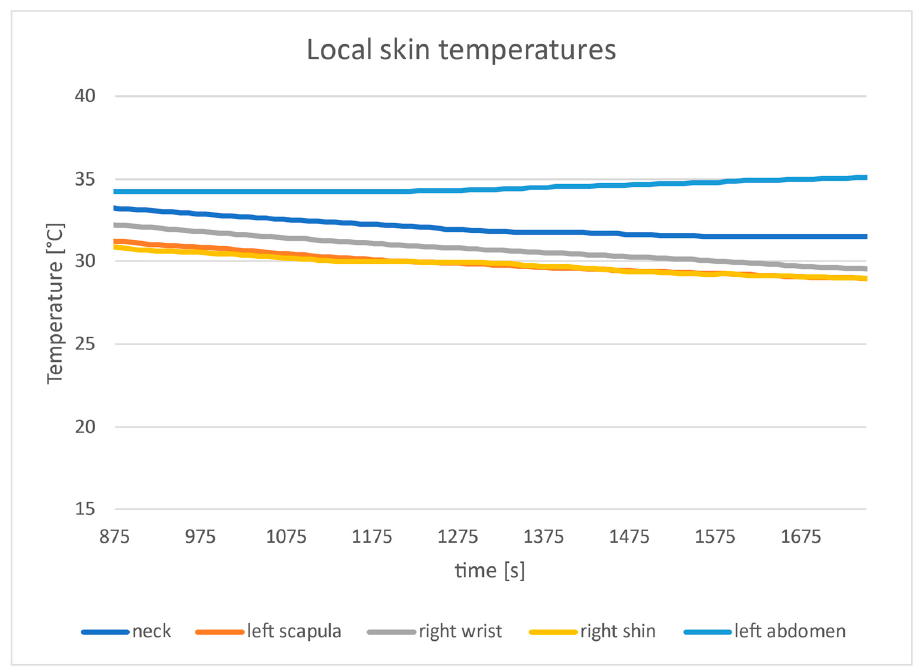
Figure 11. Local skin temperatures for participant C when adjusting to reach subjective thermal comfort.